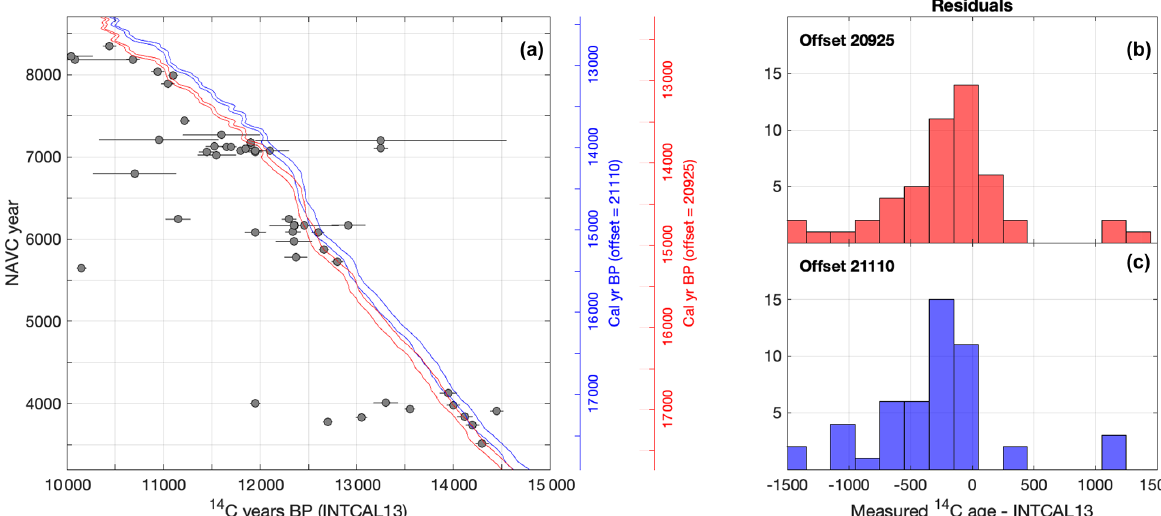
Figure 23. (a) Alignment of radiocarbon ages of plant macrofossils in NAVC varves (Ridge et al., 2012; Thompson et al., 2017) with the INTCAL13 radiocarbon calibration curve for values of the NAVC–GICC05yrBP offset estimated from 10 Be flux matching (Figs. 18, 22) and the assumption that GICC05 years are equivalent to calendar years. The bands outlined in red and blue are the 68% uncertainty bounds for the INTCAL13 calibration assuming offsets of 20925 and 21110, respectively. The histograms in (b) and (c) show residuals defined as the difference between the measured radiocarbon age of a sample from a particular varve year and the age predicted for that year by the INTCAL13 calibration and the selected